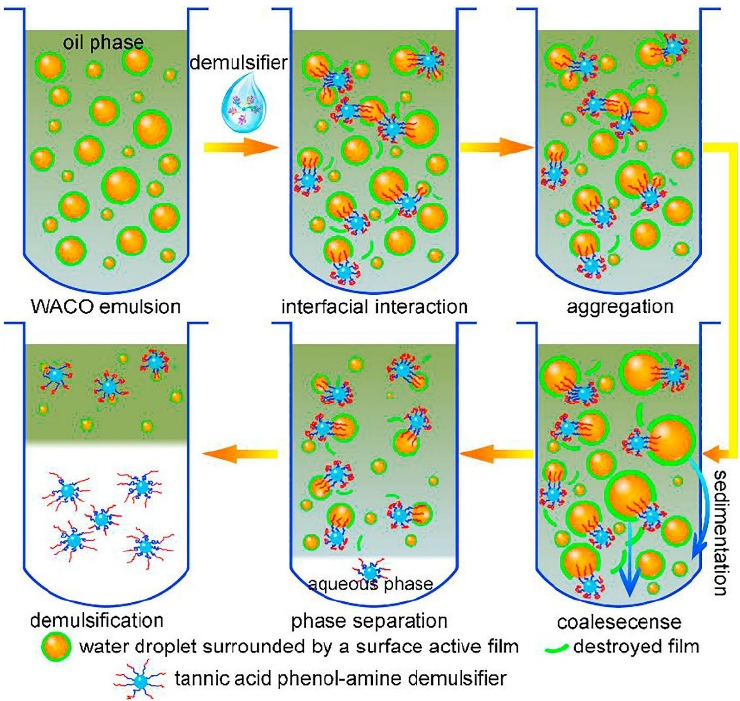
Figure 21. Schematic demulsification mechanism of tannic acid-based polyether demulsifier in heavy oil–water emulsions. Reprinted with permission from Ref. [29]. Copyright 2018, copyright the Elsevier. More details on Copyright and Liscensing are available via the following link: https://www.sciencedirect.com/.